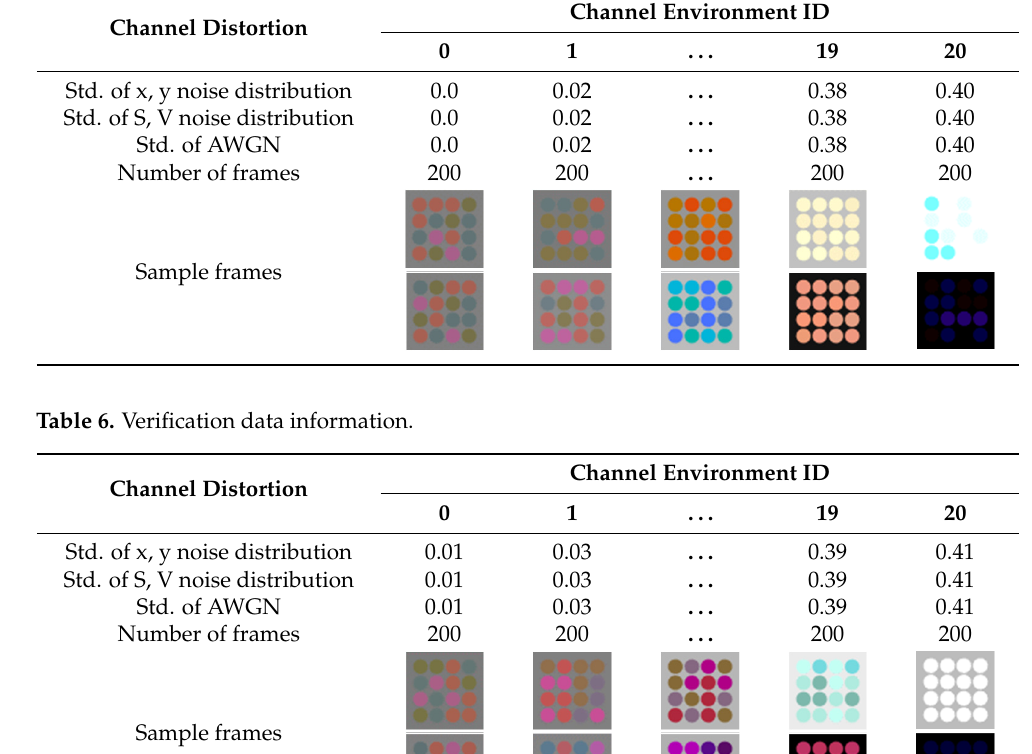
Table 5. Training data information.